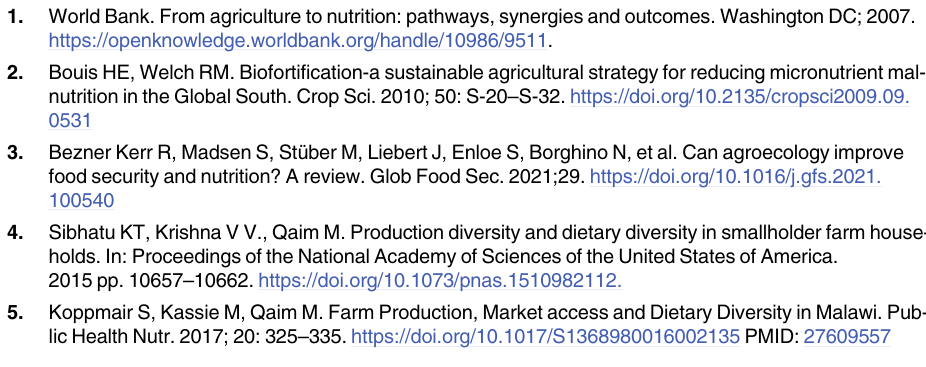
S1 Table. Value of agricultural production by food group. S2 Table. Values of consumption expenditure by food group. S3 Table. Intermediate (first stage) results from IV mediation analysis. S4 Table. Impact on production diversity and dietary diversity (by diversity index). S5 Table. Reduced form regressions for production and dietary diversity. S6 Table. ATT and ATE effects on household dietary diversity